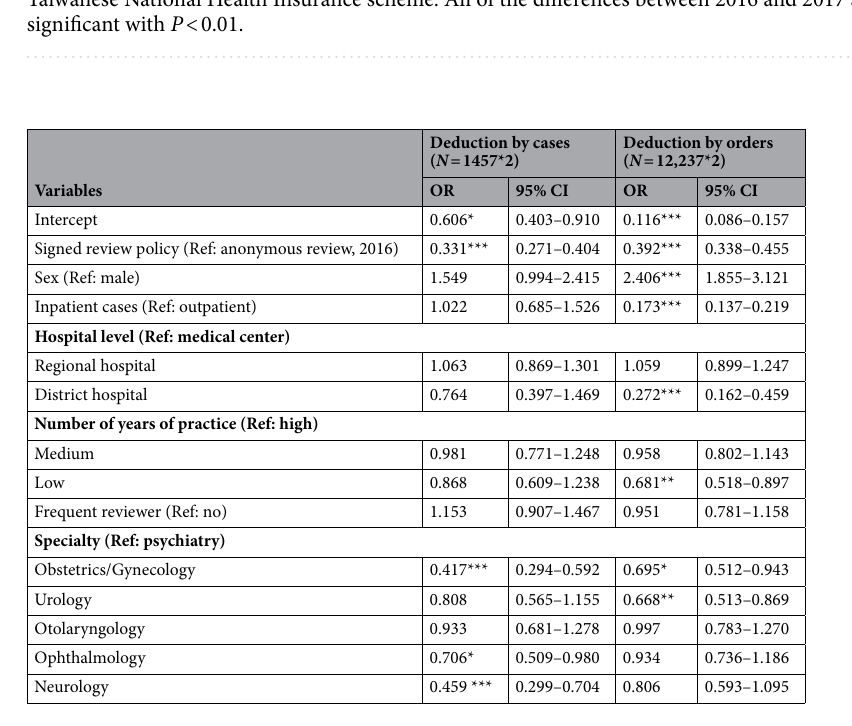
Table 3. GEE models examining the effects of the signed review policy on the likelihood of deduction under the Taiwanese National Health Insurance scheme. * P < 0.05, ** P < 0.01, *** P < 0.001.